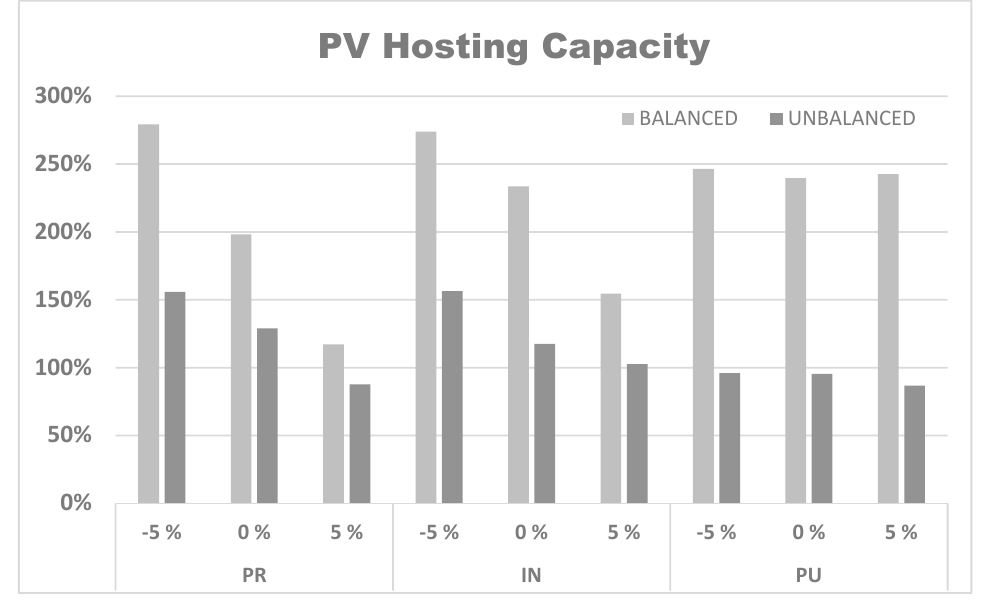
Figure 5. Photo-voltaic (PV) hosting capacity for balanced and unbalanced PV feed-in, for domestic customers.